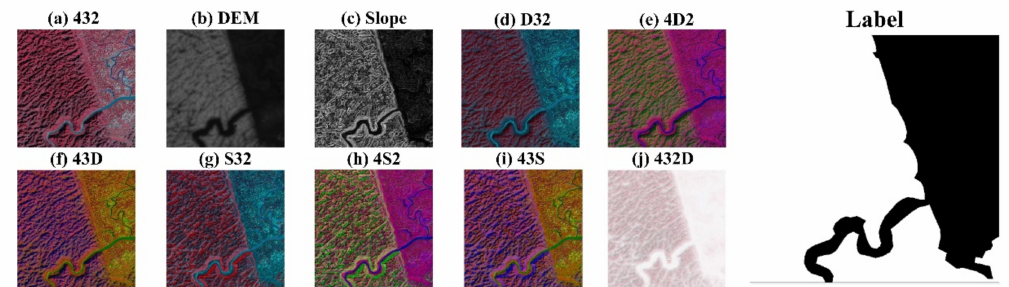
Figure 5. Examples of ten sets training samples generated in this study and the corresponding labeled result. ( a ) An example of optical remote sensing image training samples; ( b ) An example of DEM data training samples; ( c ) An example of slope data training samples; ( d – i ) Examples of three-channel fusion training samples; ( j ) An example of four-channels RGB-D training